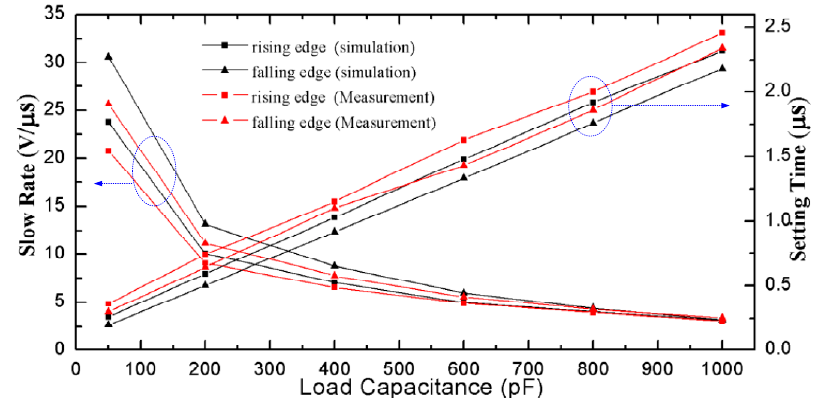
Figure 12. The measured slow rates and setting time for different load capacitances under a voltage swing of 5 V.